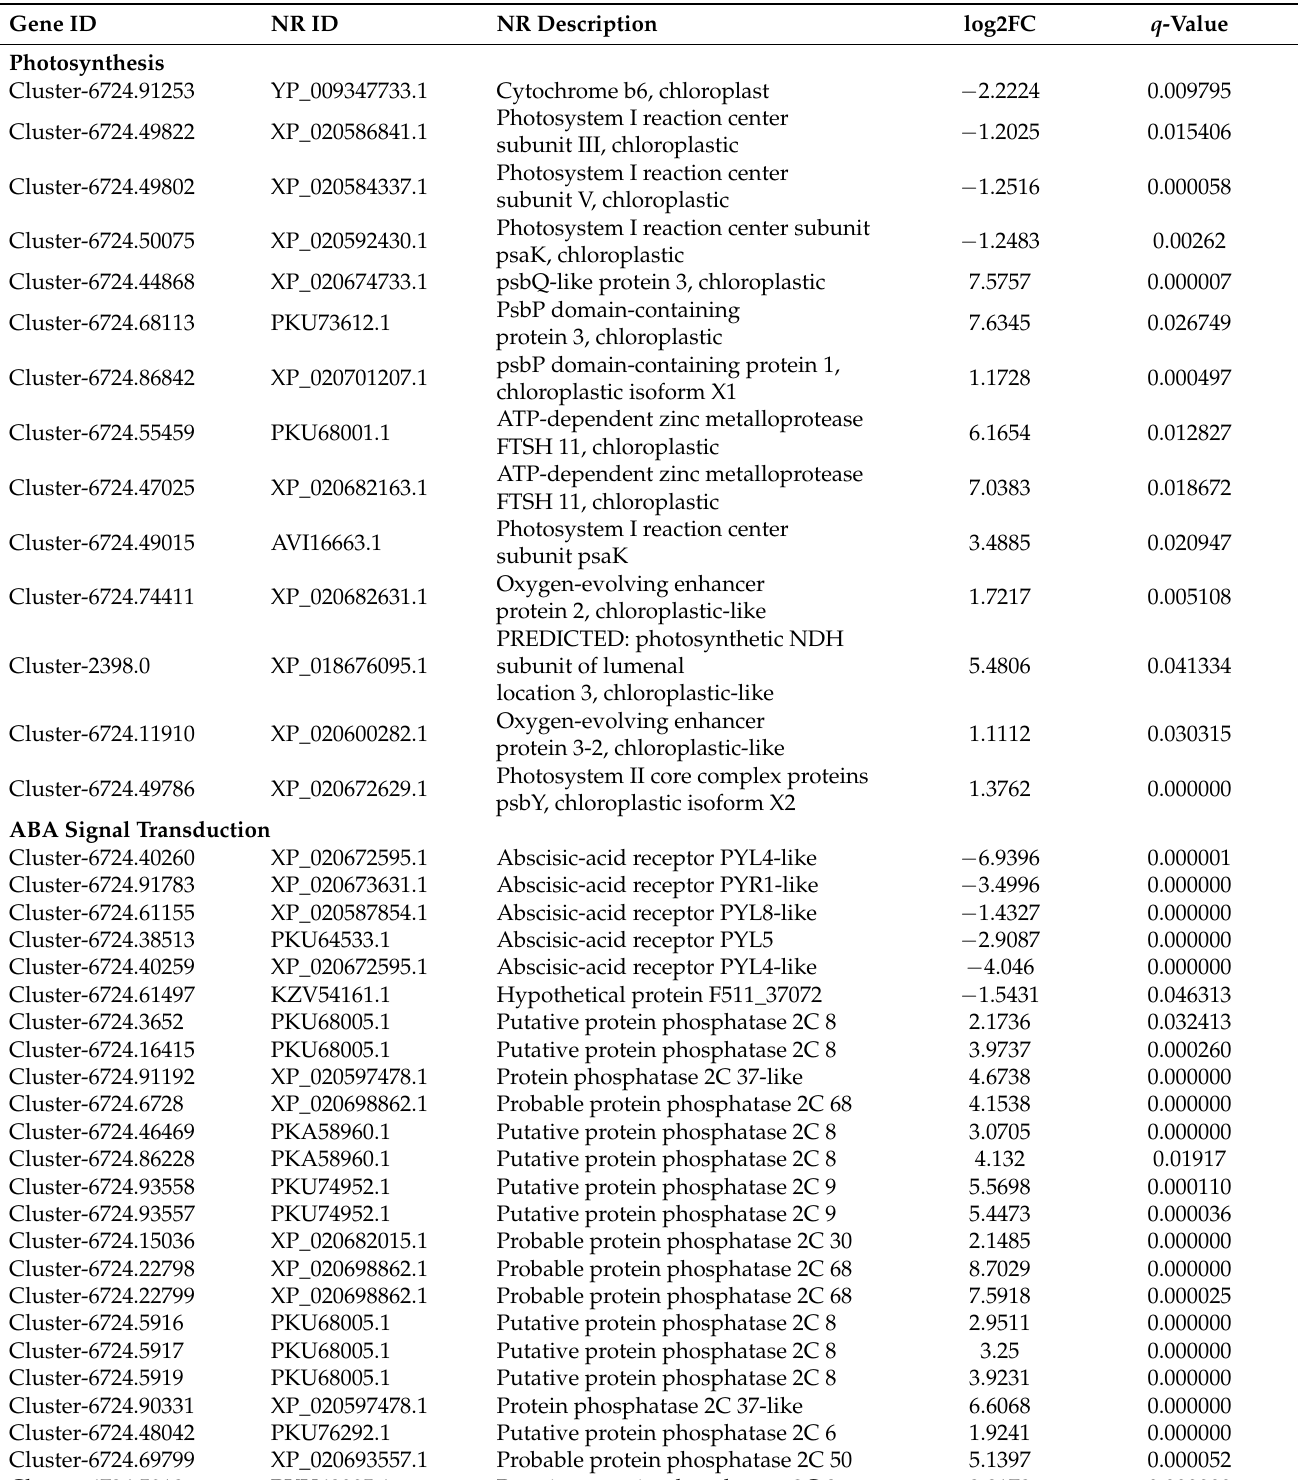
Table 3. DEGs related to photosynthesis, ABA signal transduction, and antioxidant metabolism in B. striata under drought